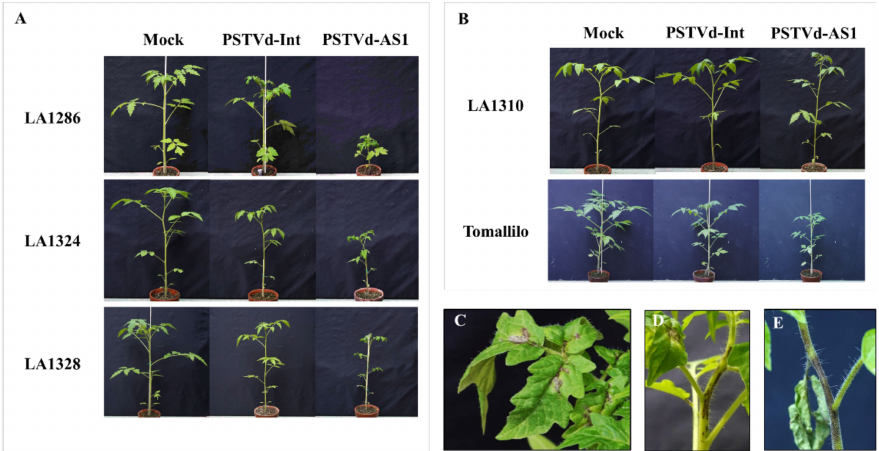
Figure 3. Wild tomatoes ( S. l. cerasiforme ) including PSTVd-sensitive or -tolerant accessions. Wild tomato accessions showed sensitivity or tolerance to PSTVd infection. ( A ) Three accessions of wild tomatoes were PSTVd-sensitive and showed severe stunting and leaf curling during PSTVd infection. ( B ) Two accessions of wild tomatoes were PSTVd-tolerant; LA1310 plants exhibited shortening of petiole length but no significant symptoms during PSTVd-AS1 infection. Stunting and mild leaf curling were observed only in ‘Tomallilo’ plants infected with PSTVd-AS1. ( C , D ) Severe vein and stem necroses were observed in PSTVd-sensitive wild tomato LA1286 during PSTVd-AS1 infection. ( E ) Highly severe stem necrosis in LA1324 plants resulted in